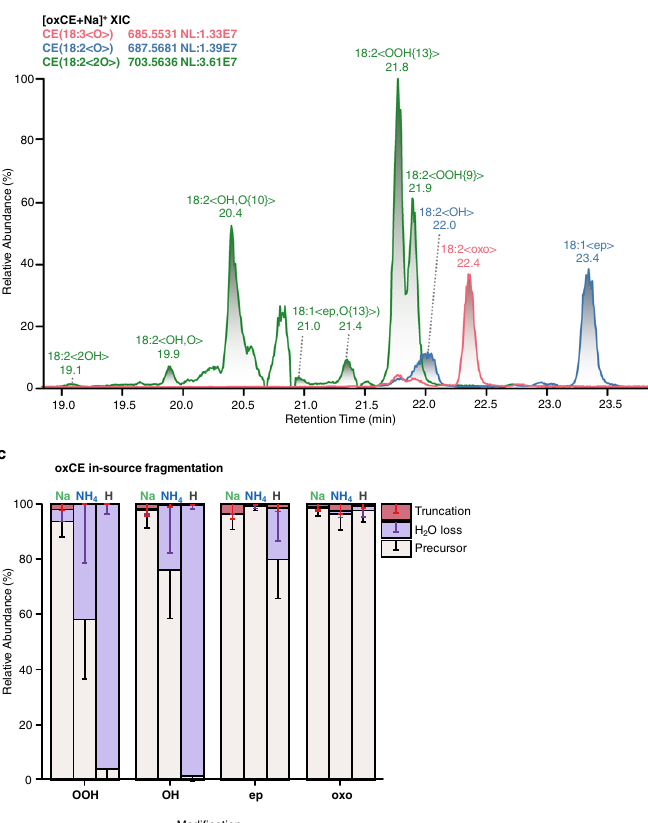
( d ) lipids was shown to be ionization- and modi fi cation type-speci fi c. ISF was cal- culated based on the parent and product peak areas using the formula ISF= PeakArea Product ×100. Relative abundances of ISF-derived species PeakArea Product +PeakArea Parent ð Þ (truncationandwaterloss)foroxCE( c )andoxTG( d )represent(mean±SD)values calculated for 10 species. Source data are provided as a Source Data fi